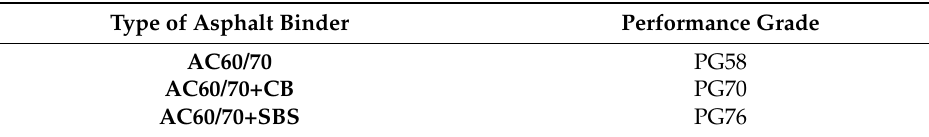
Table 3. PGs of asphalt binders.